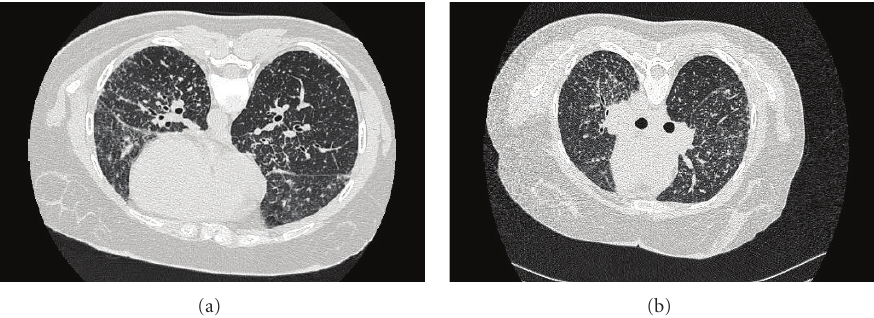
Figure 2: High resolution computed tomography showed multiple small nodules throughout the lung, few peribronchovascular nodules, with multiple enlarged mediastinal and hilar lymph